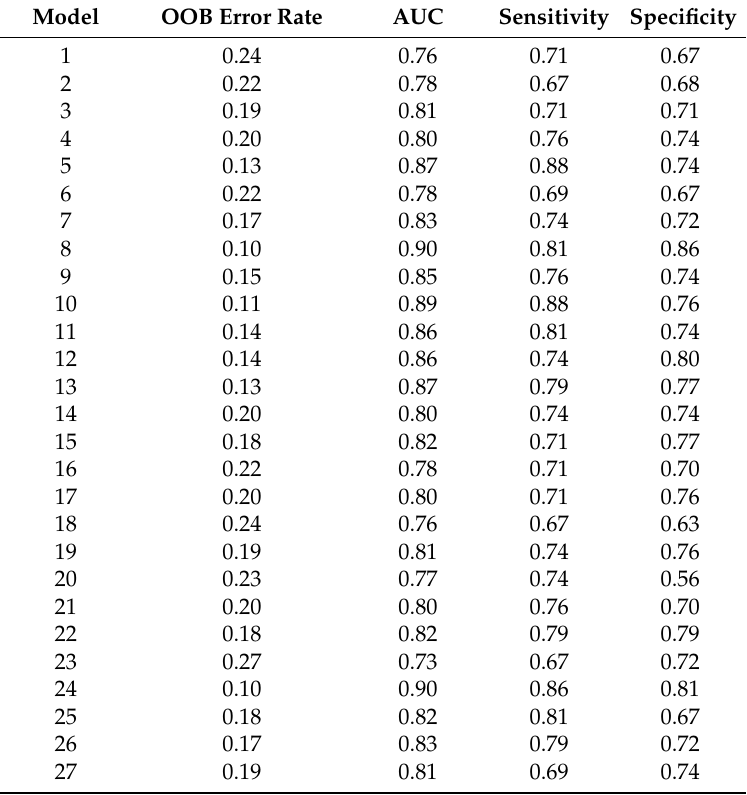
Table 2. The average out-of-bag (OOB) error rate, AUC, sensitivity, and specificity across the 27 models are 0.18 ± 0.04, 0.82 ± 0.04, 0.75 ± 0.06, and 0.73 ± 0.06, respectively. Table 2. Integrated genetic-epigenetic Random Forest model prediction performance in the training set.